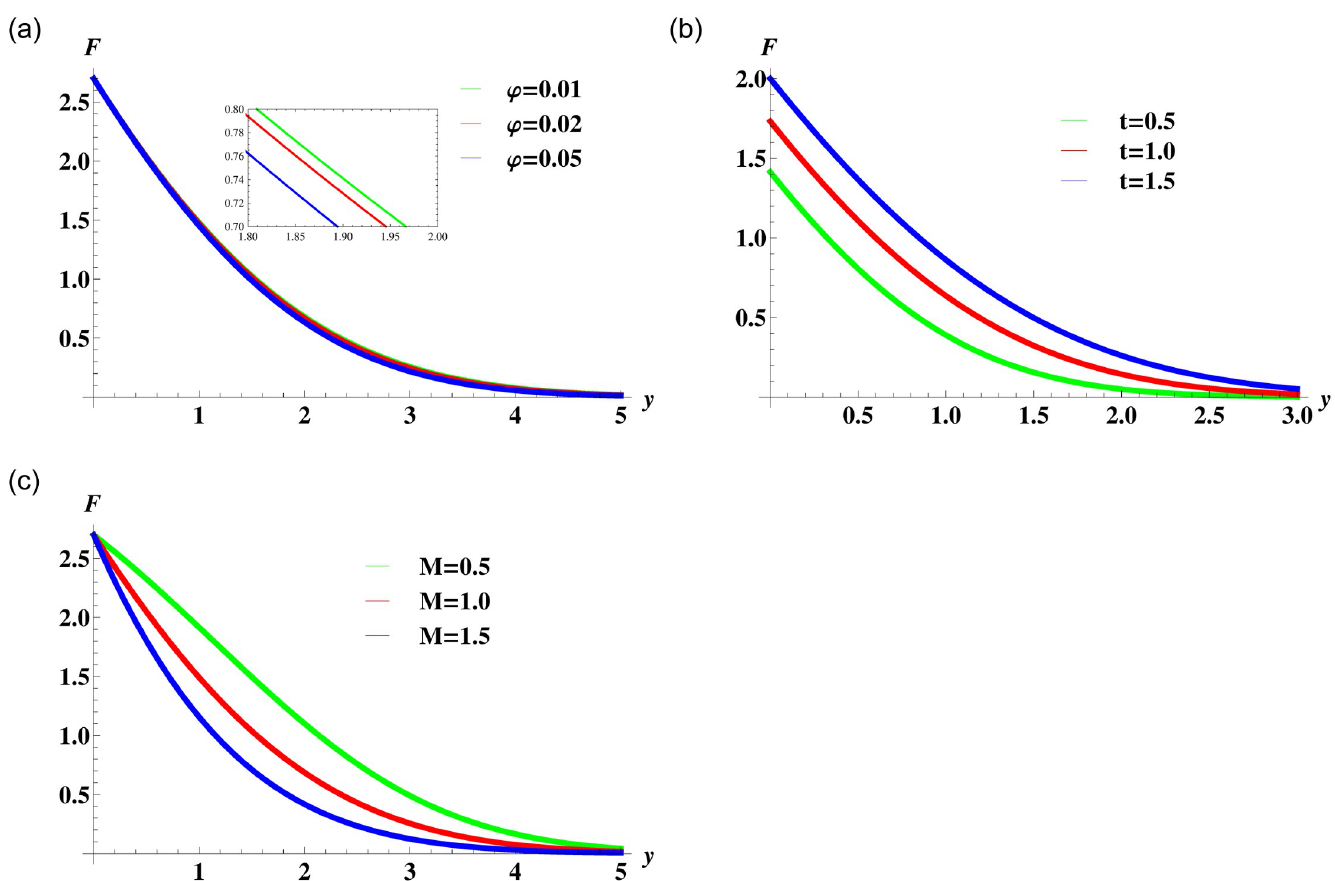
Fig 6. Velocity profile (50) for various values of φ , t and M when ρ s = 8933, ρ f = 997.1 σ s = 5.5 × 10 − 6 and σ f = 5.96 × 10 7 are fixed.